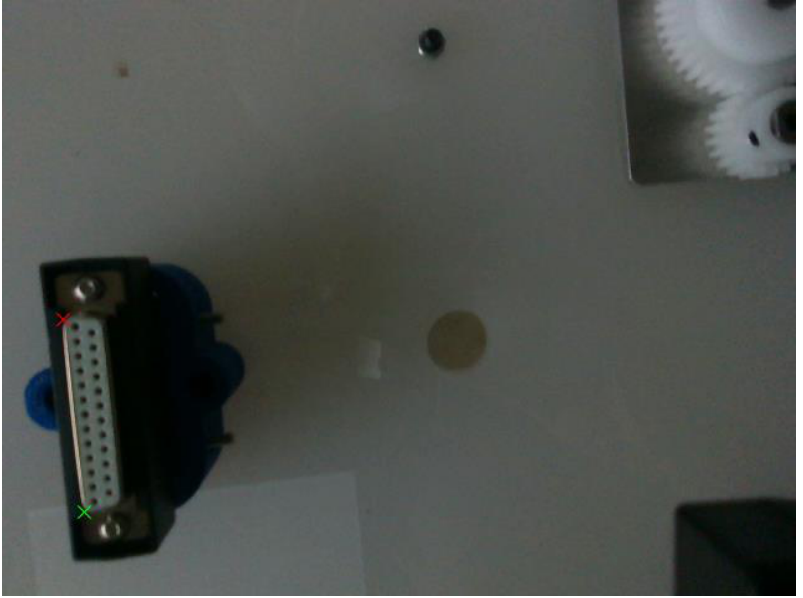
Figure 19. Workpiece landmark detection.